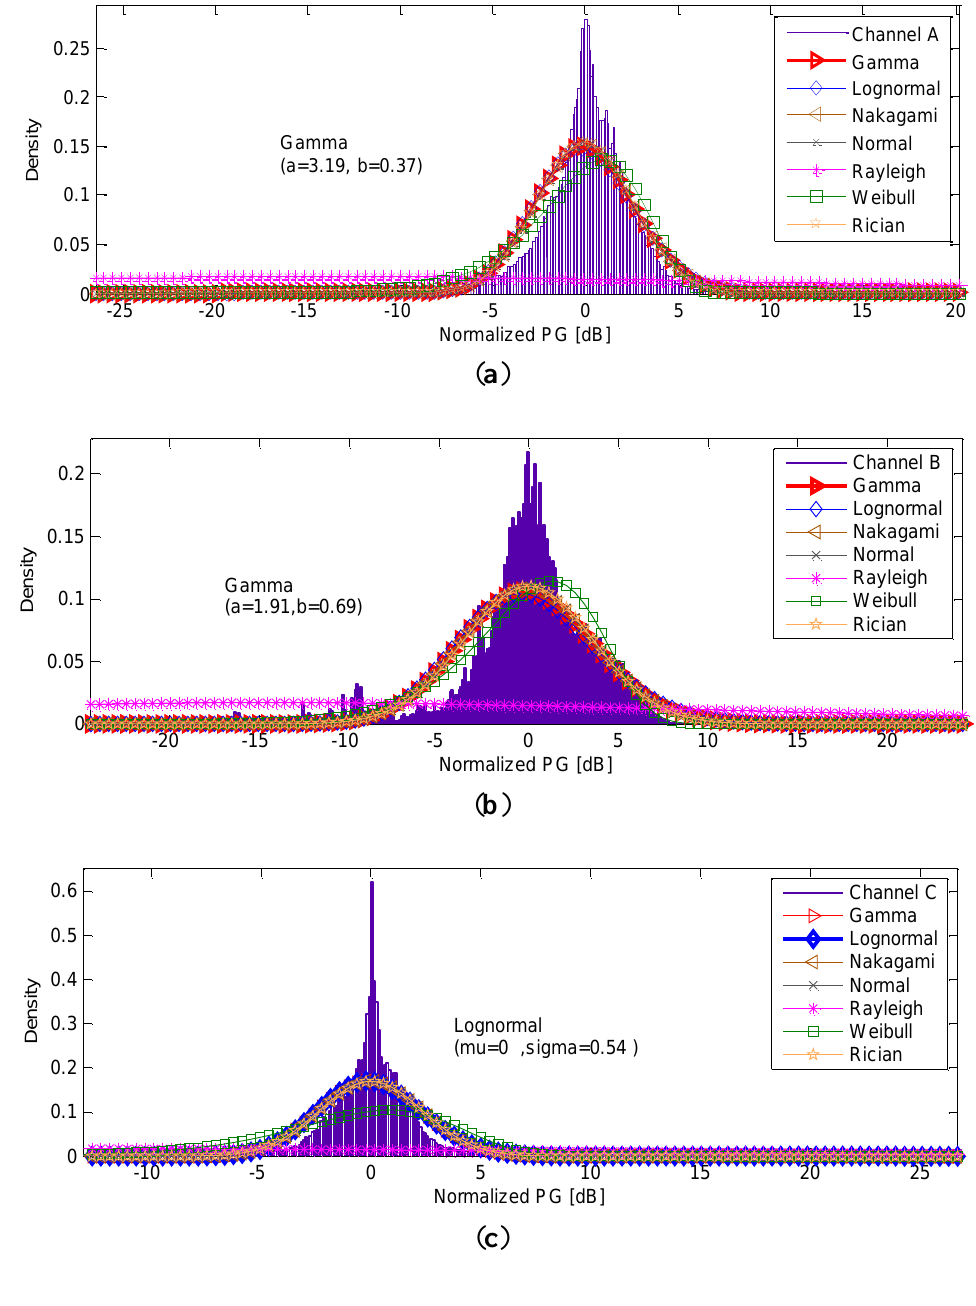
Figure 4. PDFs and distribution fits for ( a ) channel A, ( b ) channel B and ( c ) channel